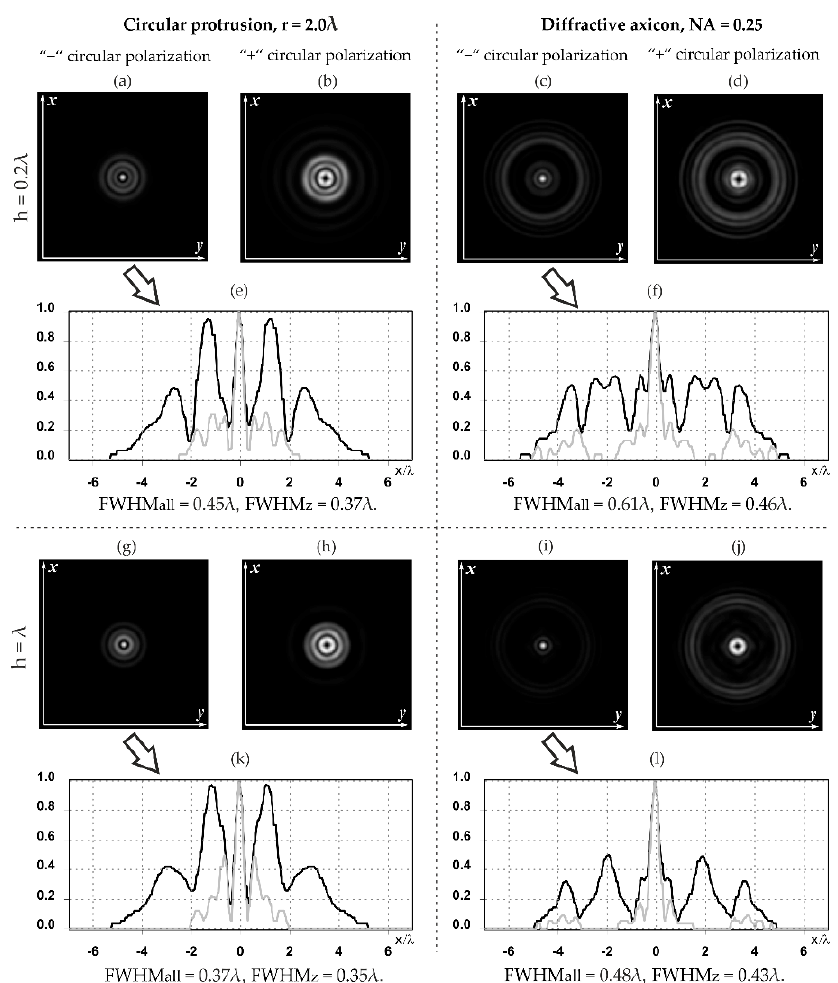
Figure 9. The redistribution of the longitudinal component of the electric field at circular polarization for a circular protrusion, r = 2.0 λ , z 1 = 0.5 λ —( a , b , g , h ) and a diffractive axicon, NA = 0.25, z 1 = 0,2 λ —( c , d , i , j ); the graphs show a comparison of the total intensity (black) and the intensity of the longitudinal component of the electric field (gray)—( e , f , k , l ).